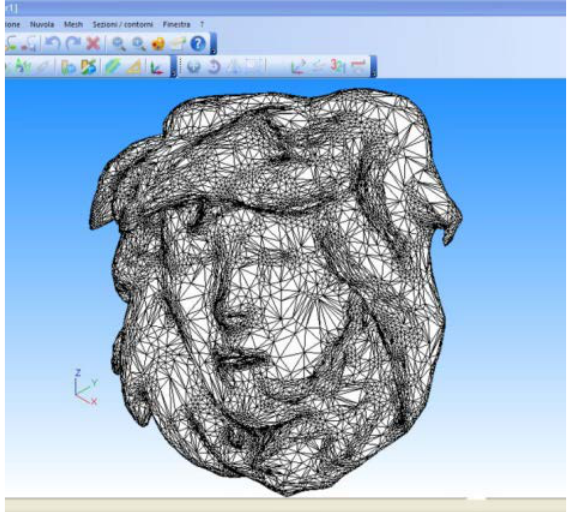
Figure 10. 3D Delaunay triangulation.